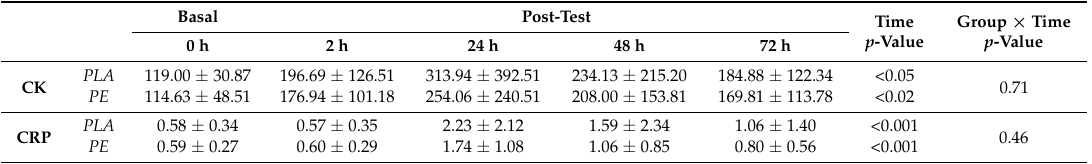
Table 5. Creatine kinase (CK) and C-reactive protein (CRP) values at baseline and 2, 24, 48 and 72 h after physical tests. Data were obtained using a paired two-tailed Student’s t -test. Data are presented as the mean with SD. Basal Post-Test Time